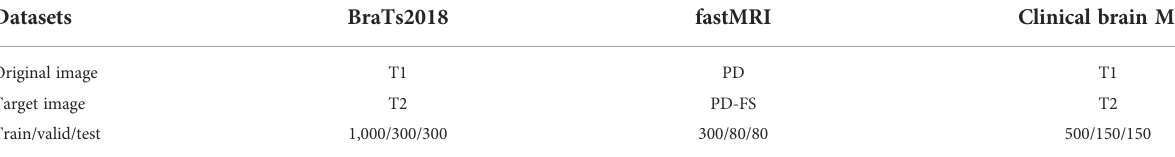
TABLE 1 Three datasets and number of images for training validation and test.